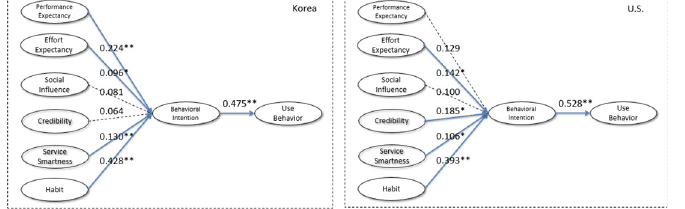
Figure 3. Comparison between South Korea and